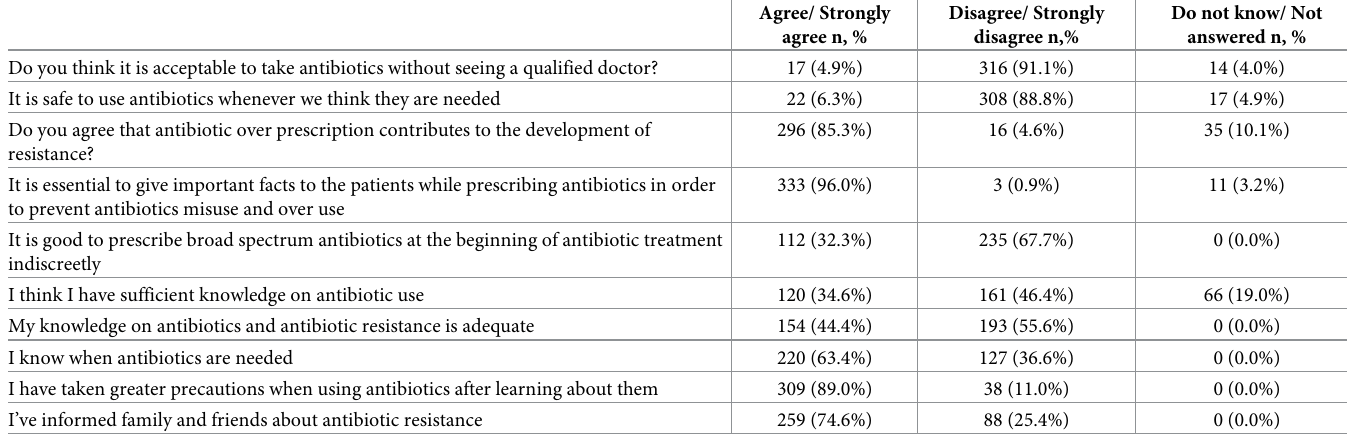
Table 6. Responses related to confidence and perception on antibiotics